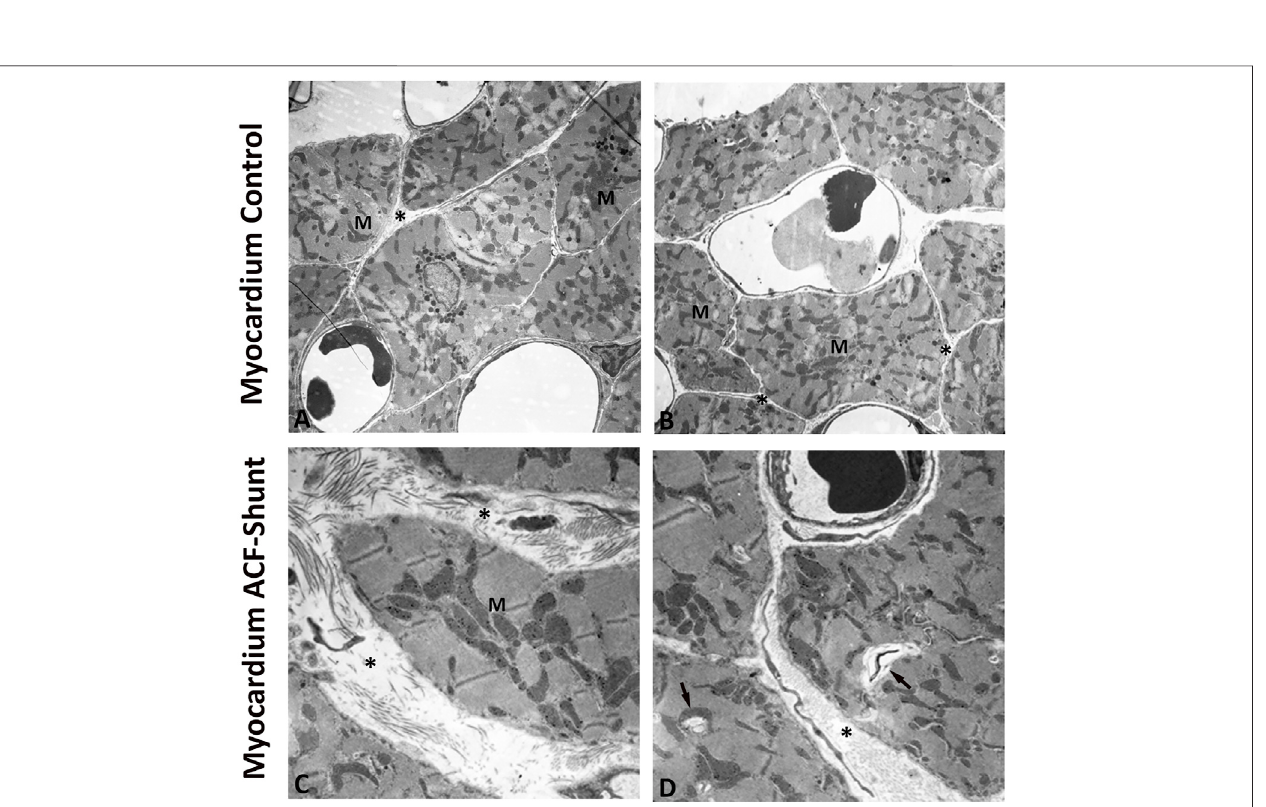
FIGURE 4 | Electron micrographs of the left ventricle (LV) from controls (A , B) and rats with ACF-induced volume overload (C , D) . A and B display cross sections of control hearts showing intact myocardial tissue with speci fi c cell – cell contacts and regular intercellular spaces (see *), cardiomyocytes with well-organized numerous cardiomyo fi bersandintactmitochondriawithapreservedinternalarchitecture. (C , D) showultrastructurechangesoftheleftventricleat28±2 daysafterACFinduction.Note thewideningoftheintercellularspace(see*),degeneratedmyo fi bers(arrow)anddisorganizedcellorganelles.Inaddition,manymitochondria(M)showedultrastructural abnormalities such as size enlargement with amorphous dense bodies and disruption of the internal architecture. Magni fi cation: (A) × 10.000; (B) × 20.000, bar = 1 μ m.